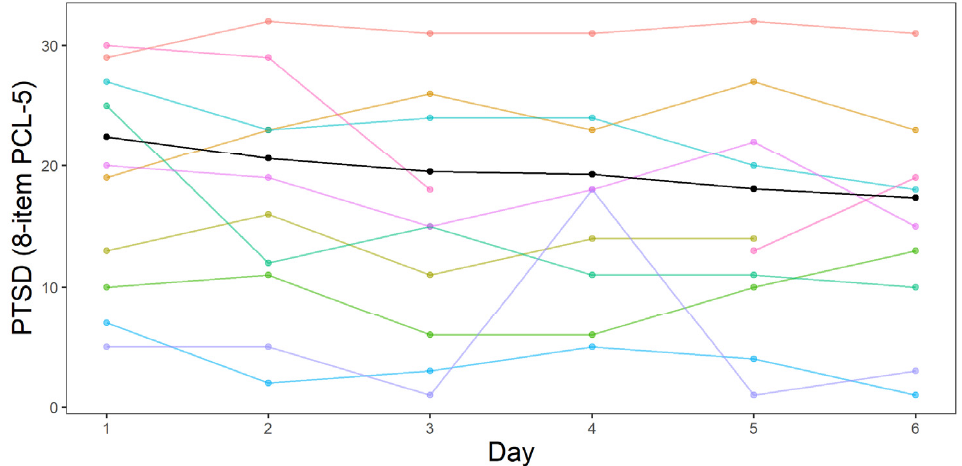
Figure 3. PTSD symptomatology during treatment, as measured with the 8-item PCL, of a sample of 10 participants (see the online Supplementary Materials for the complete sample). The y -axis represents total score on the 8-item PCL. The x -axis represents treatment day. The black line represents the observed mean PTSD symptomatology over time, whereas the colored lines represent individual trajectories. Table 2. Descriptive data for the follow-up treatment outcomes and the daily 8-item PCL.